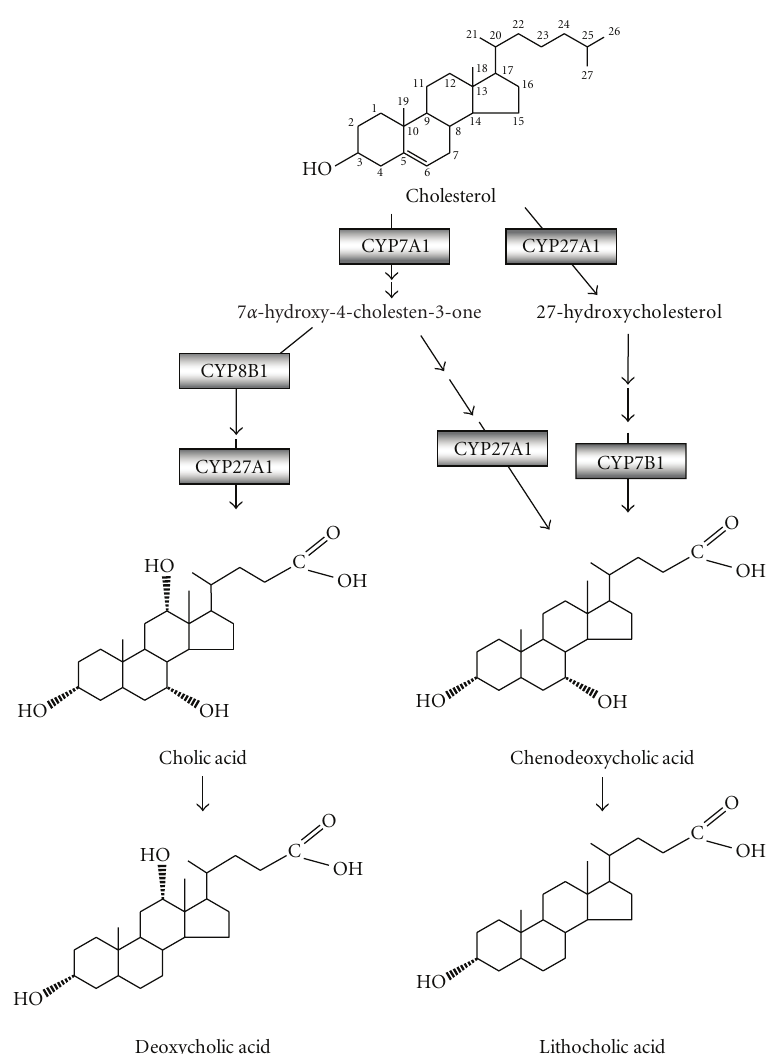
Figure 1: Bile acid synthesis. Bile acids are synthesized from cholesterol in the liver through two pathways: the classic pathway and the alternative pathway. In human liver, bile acid synthesis mainly produces two primary bile acids, cholic acid (CA), and chenodeoxycholic acid (CDCA). Key regulatory enzymes in both pathways are indicated. CYP7A1 catalyzes the first the rate-limiting step in the classic pathway to convert cholesterol into 7 α -hydroxycholesterol, while CYP27A1 initiates the alternative pathway by converting cholesterol into 27-hydroxycholesterol, which is then 7 α -hydroxylated by oxysterol 7 α -hydroxylase (CYP7B1). CYP8B1 regulates the cholic acid synthesis in the classic pathway. In the intestine, primary bile acid CA and CDCA are dehydroxylated at the 7 α -position by the bacterial enzymes to produce the secondary bile acids, deoxycholic acid (DCA), and lithocholic acid (LCA),